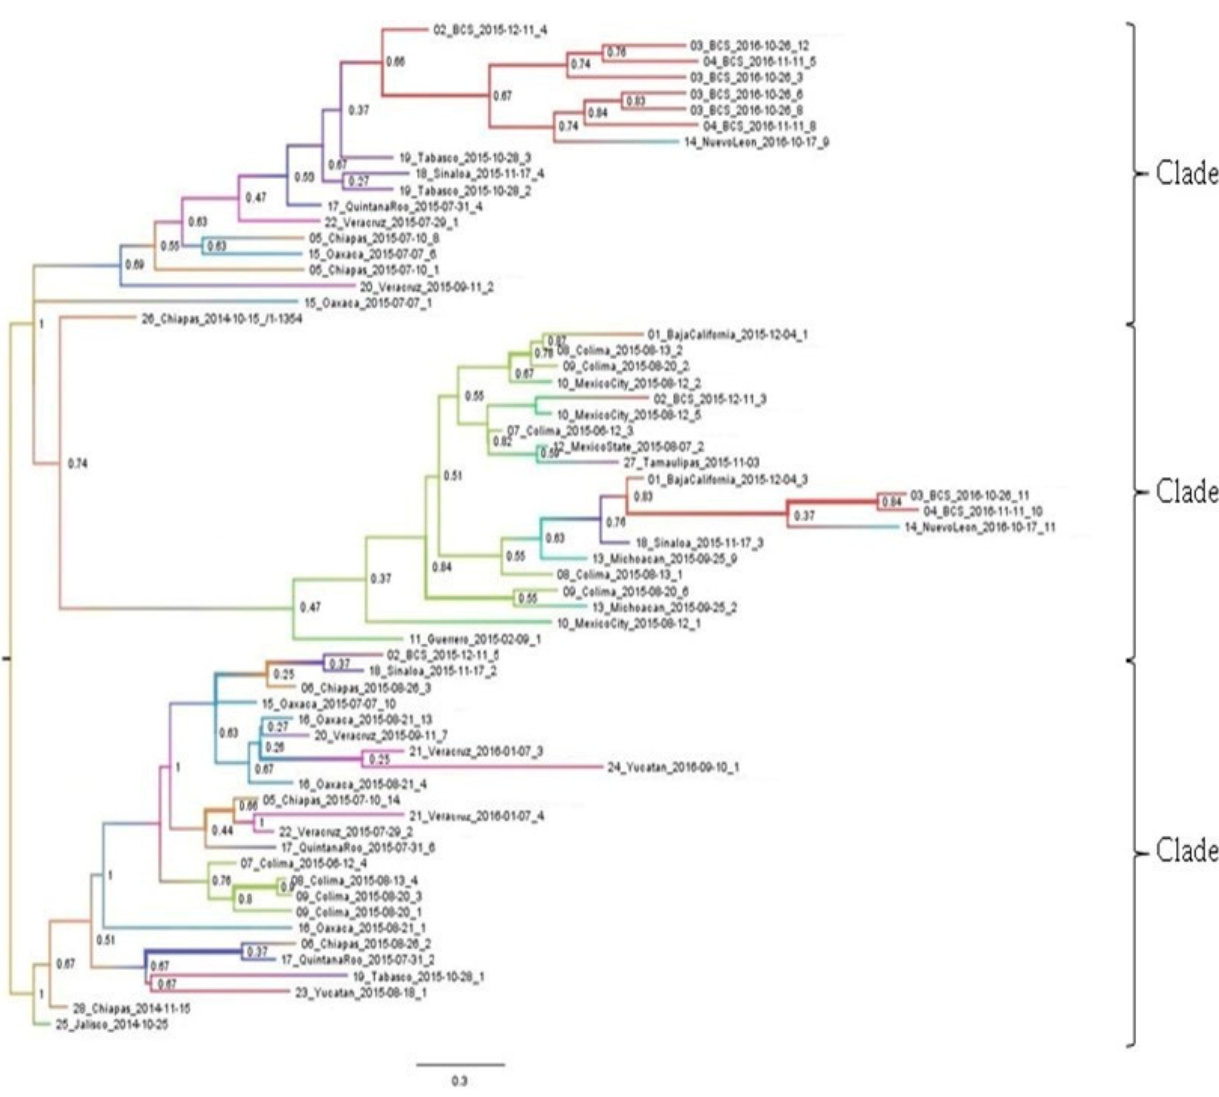
Figure 2. Phylogeography of CHIKV during the outbreak 2014–2016 in Mexico. Maximum clade credibility phylogeographic tree of the Mexican CHIKV outbreak clade. Branch colors represent most probable inferred locations. The branch thicknesses are sized in proportion to root location probability.